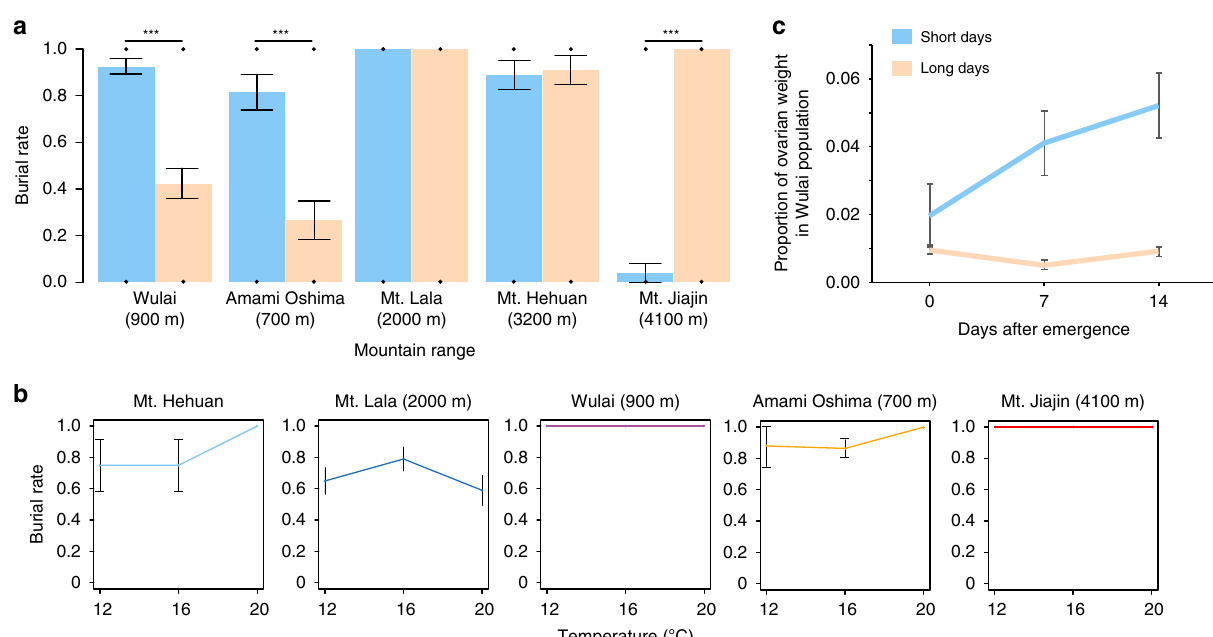
Fig. 5 Results of common garden experiment examining reproductive photoperiodism in fi ve beetle populations. a Breeding likelihood in terms of burial rates under short- (blue bar) and long-days (orange bar; Wulai: χ ² 1 = 39.93, p < 0.001, n = 126, Amami Oshima: χ ² 1 = 18.19, p < 0.001, n = 57, Mt. Hehuan, χ ² = 0.08, p = 0.78, n = 50, Mt. Lala: χ ² = 0, p = 1, n = 32, and Mt. Jiajin: χ ² = 59.51, p < 0.001, n = 49; post hoc comparison: Wulai: z = − 5.46, P < 1 1 1 0.0001, Amami Oshima: z = − 3.755, P = 0.0002, Mt. Hehuan: z = − 0.253, P = 0.8, Mt. Lala: z = − 0.981, P = 0.327, and Mt. Jiajin: z = 4.338, P < 0.0001). b Breeding likelihoods under three temperature conditions (12, 16, and 20 °C; Wulai: χ ² 2 = 3.63, p = 0.16, n = 24; Amami Oshima: χ ² 2 = 2.84, p = 0.24, n = 88; Mt. Lala: χ ² 2 = 0, p = 1, n = 44, Mt. Hehuan: χ ² 2 = 5.33, p = 0.07, n = 70; and Mt. Jiajin: χ ² 2 = 0, p = 1, n = 18). c Ovarian development in the Wulai population after emergence under short- (blue line) and long-days (orange line). The maximum elevation of each mountain range is given in parentheses (short-days: χ ² 2 = 29.25, p < 0.001, n = 55, long-days: χ ² 3 = 0.35, p = 0.95, n = 44; post hoc comparison:). All the analyses were conducted by two-sided GLM, and the p values were obtained from the two-sided tests. The standard error was presented as the error bar; p < 0.1; * p < 0.05; ** p < 0.01; *** p <